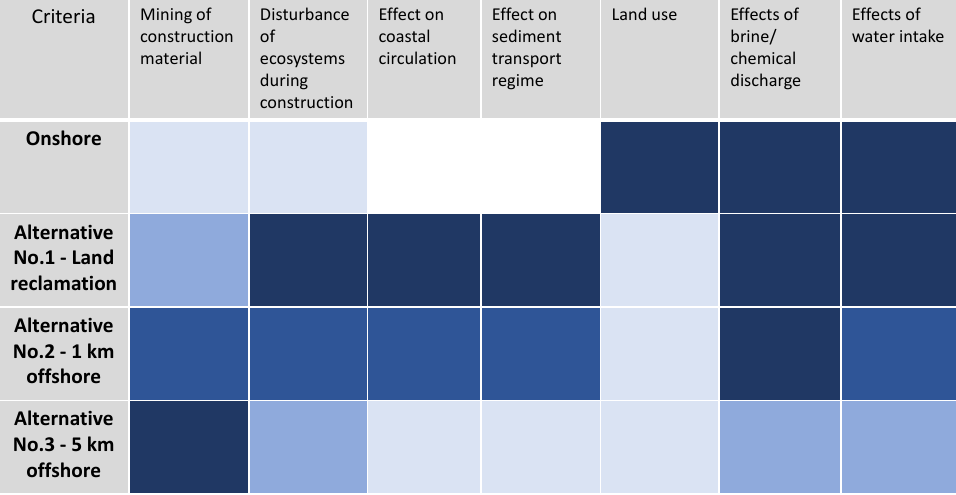
Figure 11. Heatmap for the environmental assessment of the alternatives.